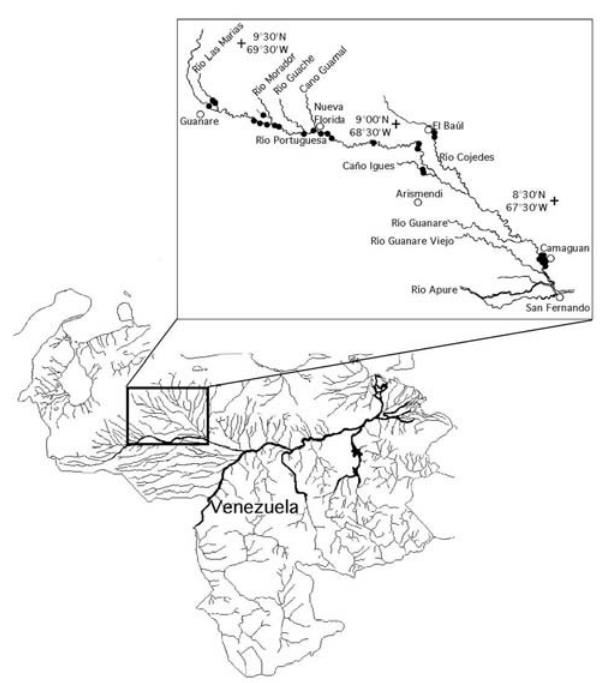
Fig.1. Map of Venezuela with inset showing locations of survey sites (n=28, filled circles) along the río Portuguesa elevational